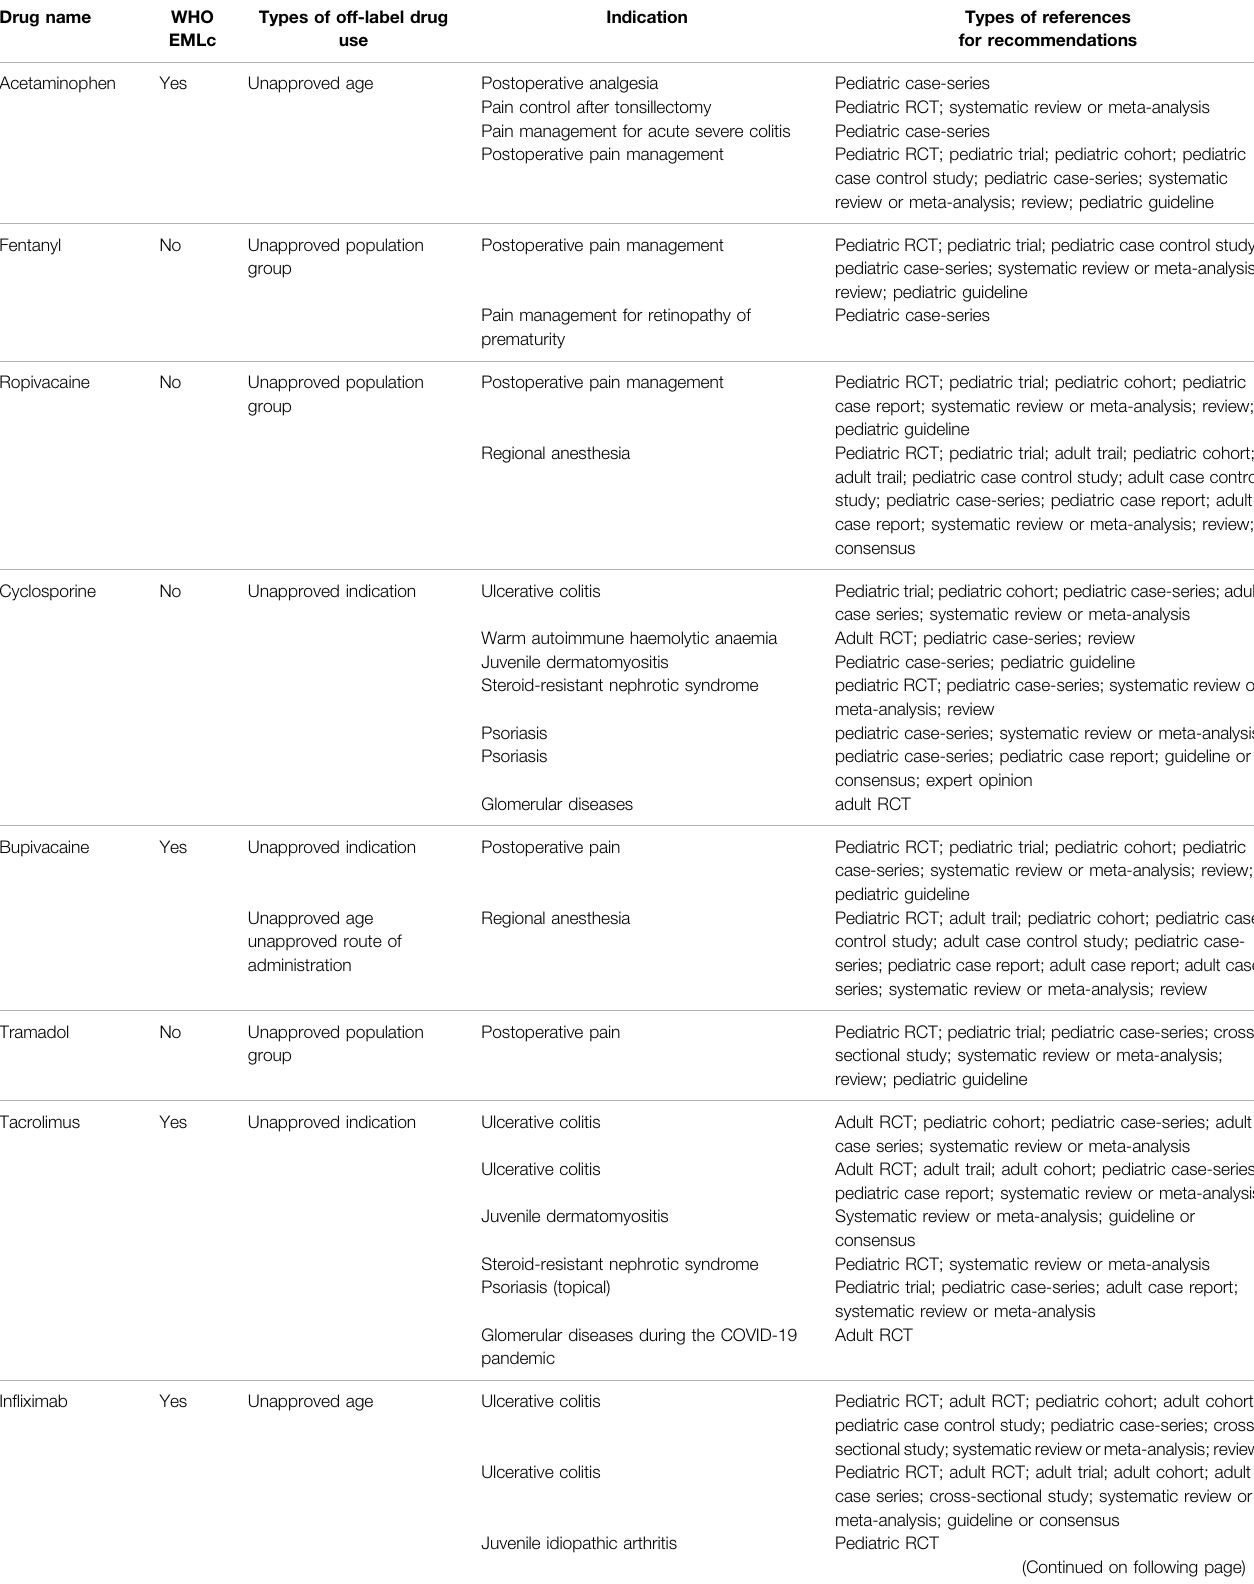
TABLE 2 | The details of the most frequently recommended off-label